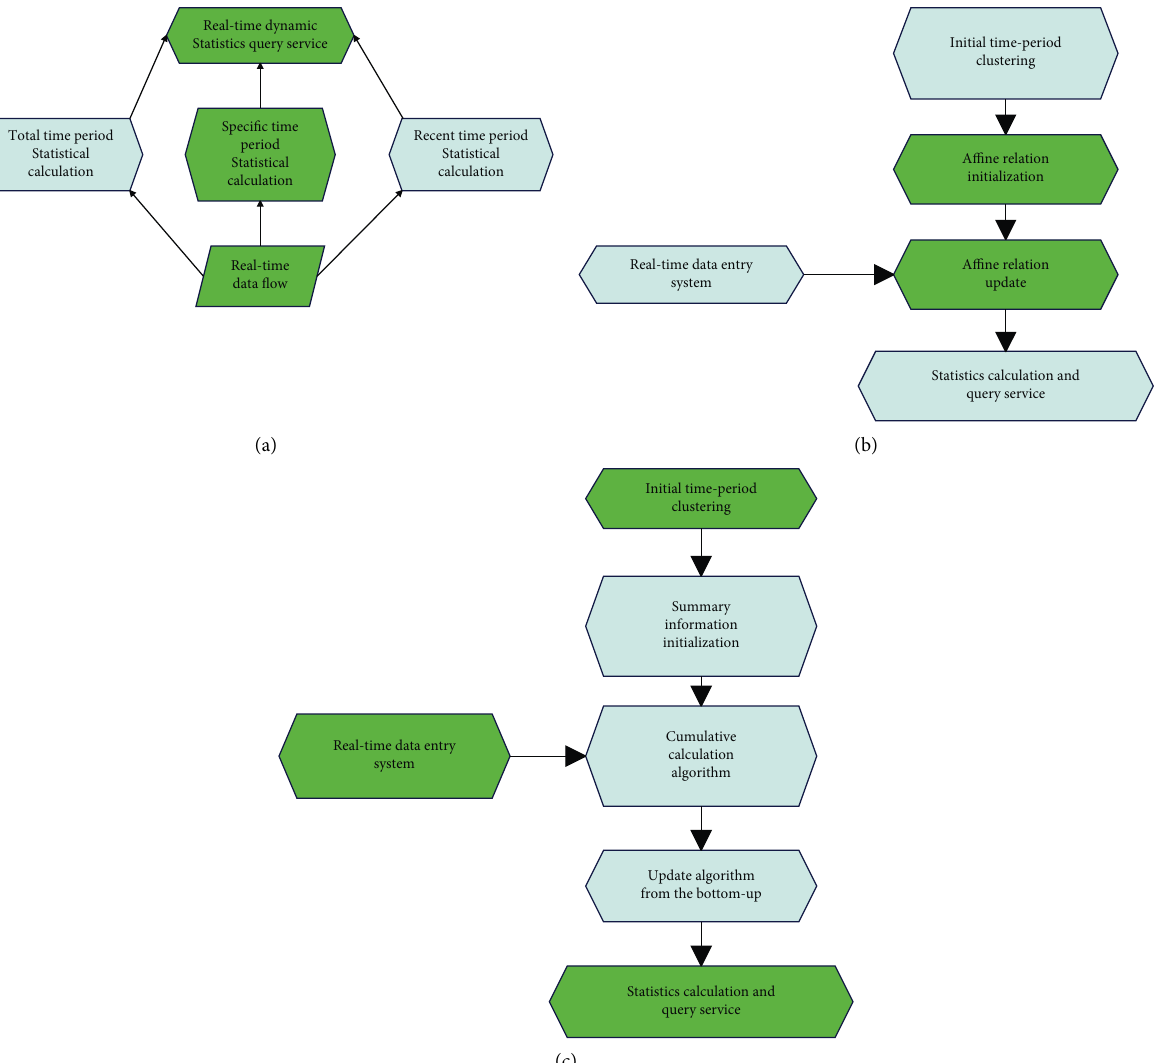
Figure 6: Time series econometric model diagram. (a) Overall design diagram of the system. (b) Landmark window processing process. (c) Sliding window multi-layer processing